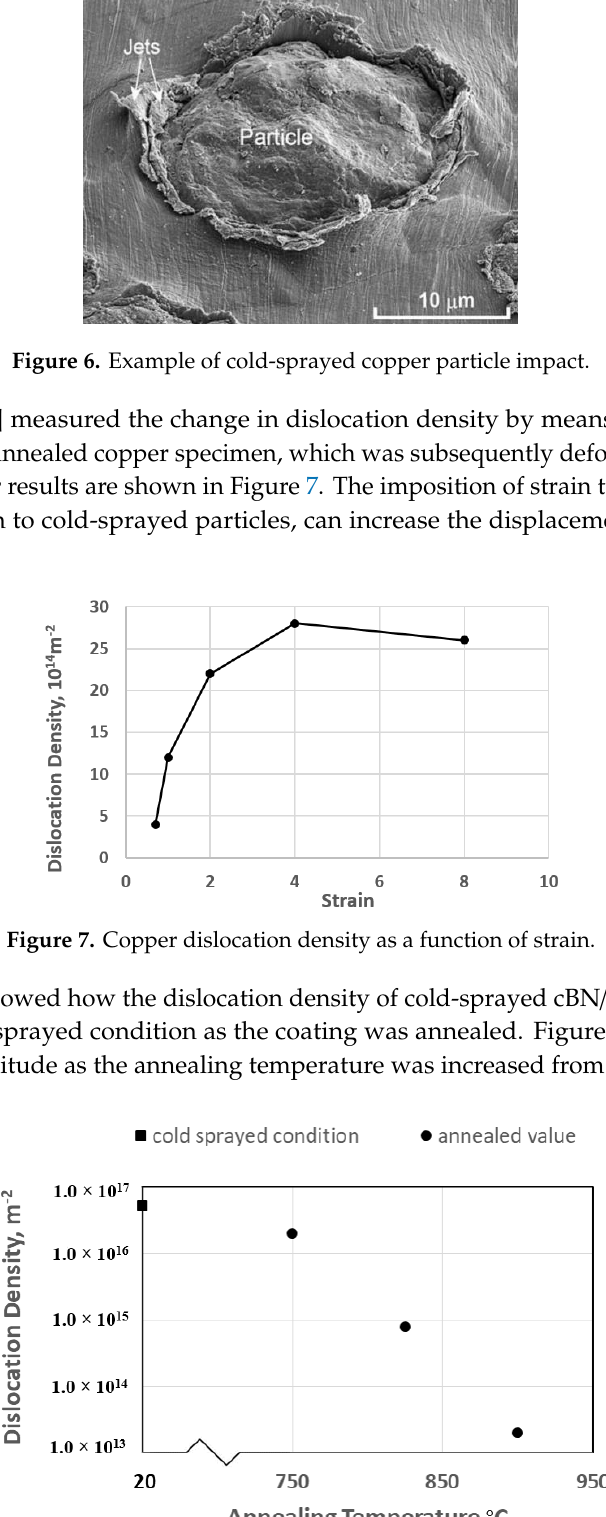
Figure 8. The displacement density of cold-sprayed cBN/NiCrAl as it is annealed.